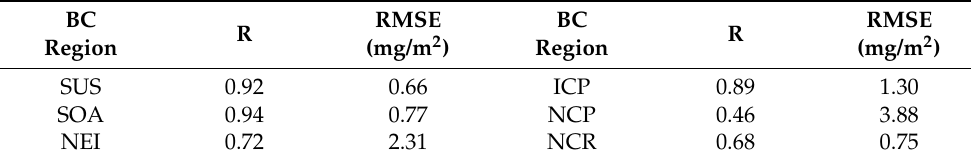
Table 4. The statistics for the comparisons of monthly BC column concentration between MERRA-2 data and POLDER/GRASP component products over the regions of interest. R indicates the correla- tion coefficient and RMSE indicates root mean square